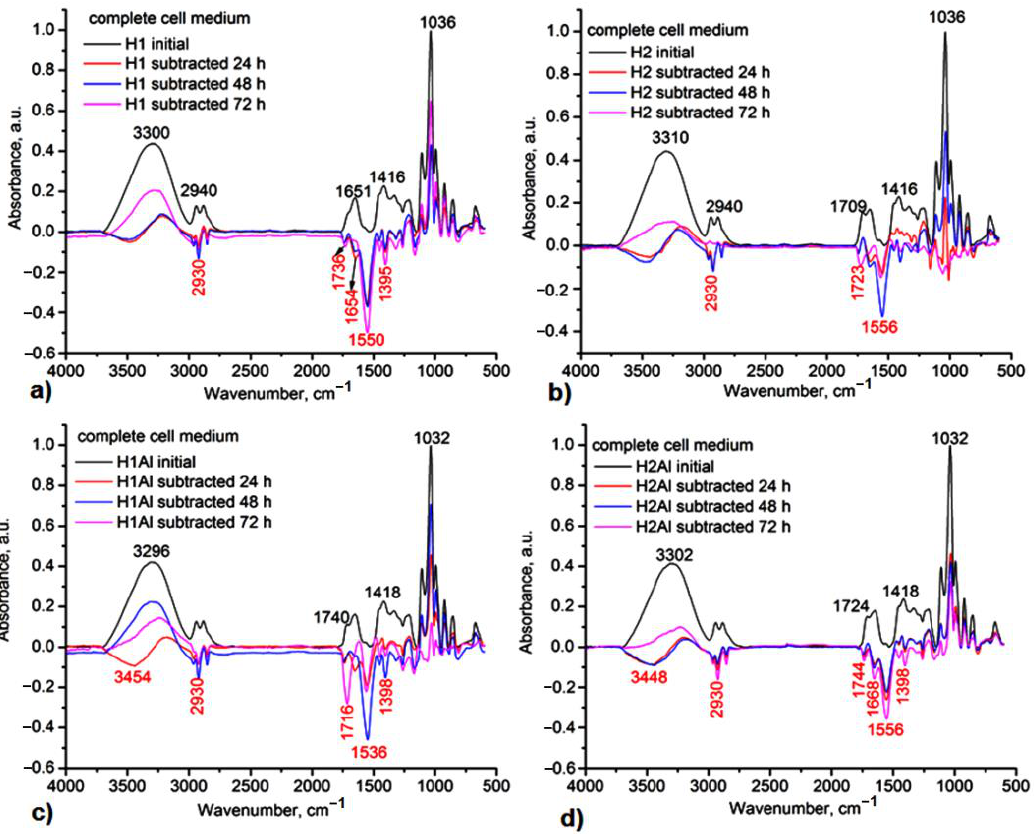
Figure 9. IR subtracted spectra of the H1-( a ), H2-( b ), H1Al-( c ), and H2Al-( d ) after 24 h, 48 h, and 72 h immersion in a complete cell medium.